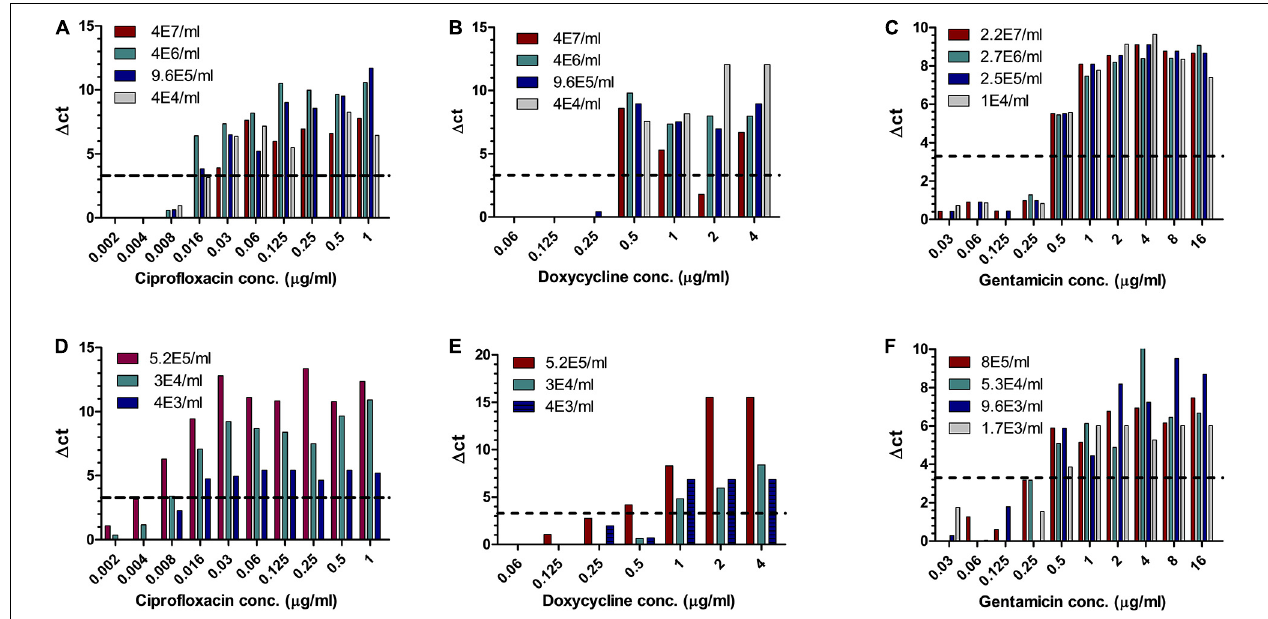
FIGURE 2 | MIC determination of blood cultures and whole blood samples spiked with Y. pestis . Human blood cultures (A–C) and human whole blood samples (D–F) inoculated with different concentrations of Y. pestis (cfu/ml) were subjected to AST for ciprofloxacin, doxycycline, and gentamicin by the MAPt analysis. MICs were determined, as described in the Materials and Methods section, by the threshold (cid:49) CT = 3.3.